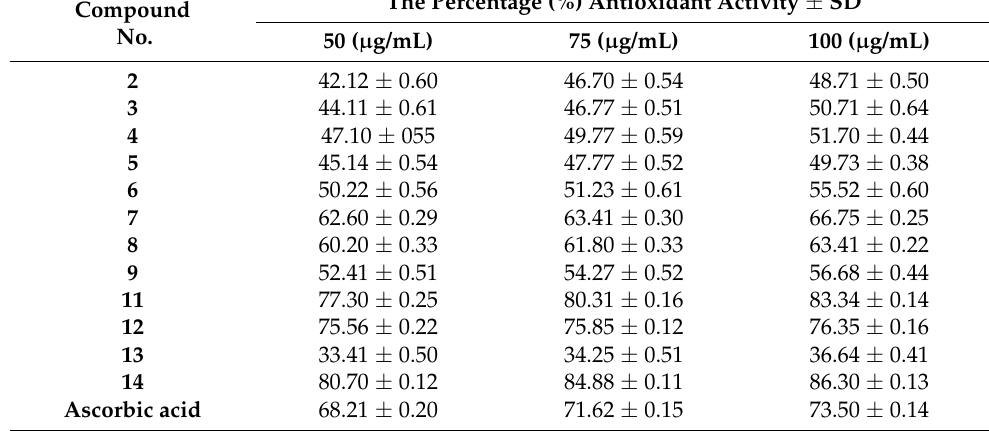
Table 1. DPPH Radical Scavenging ability of the compounds 2 – 14 relative to the standard antioxidant ascorbic